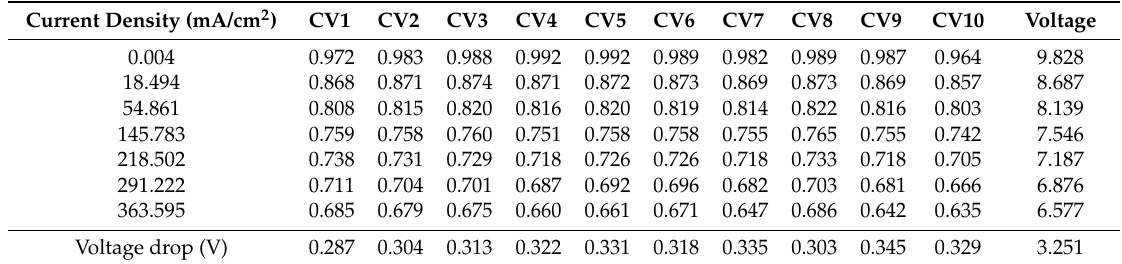
Table 6. Dynamic performance at different relative humidities